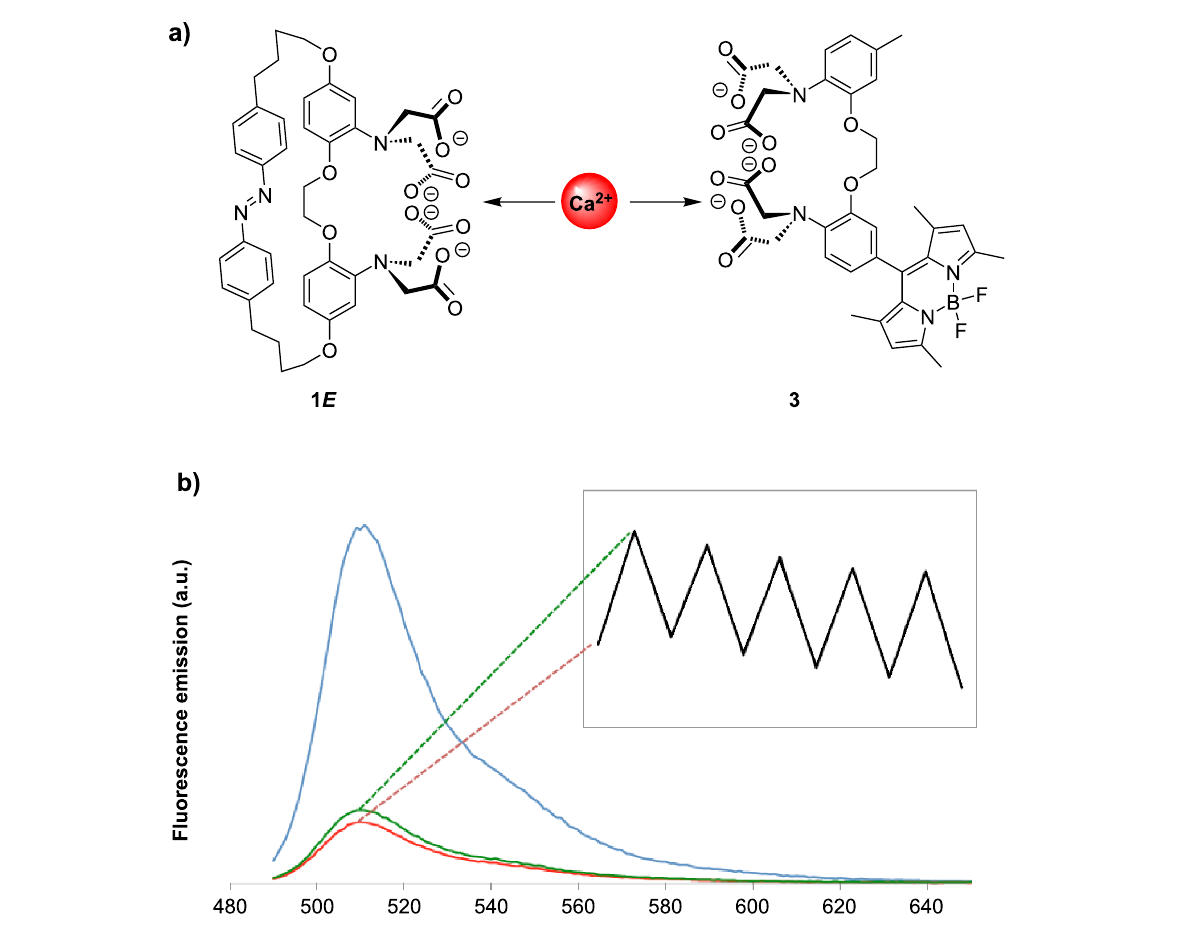
Figure 7: a) Reversible Ca 2+ exchange between photoregulated host 1 and turn-“on” fluorescent probe 3 . b) Blue: 3 (5 µM) in 0.1 M KCl and added Ca 2+ (5 µM) in aqueous 0.03 M MOPS buffer at pH 7.2, red: after the addition of 50 µM 1 E , green: after photoirradiation at 365 nm. Inset: fluorescent response over 5